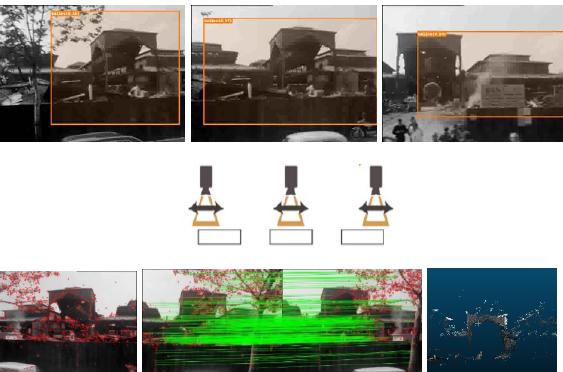
Figure 9. Results of the photogrammetric processing of the frames from the film footage “La Destruction des Halles de Paris” shot with trucking camera motion.